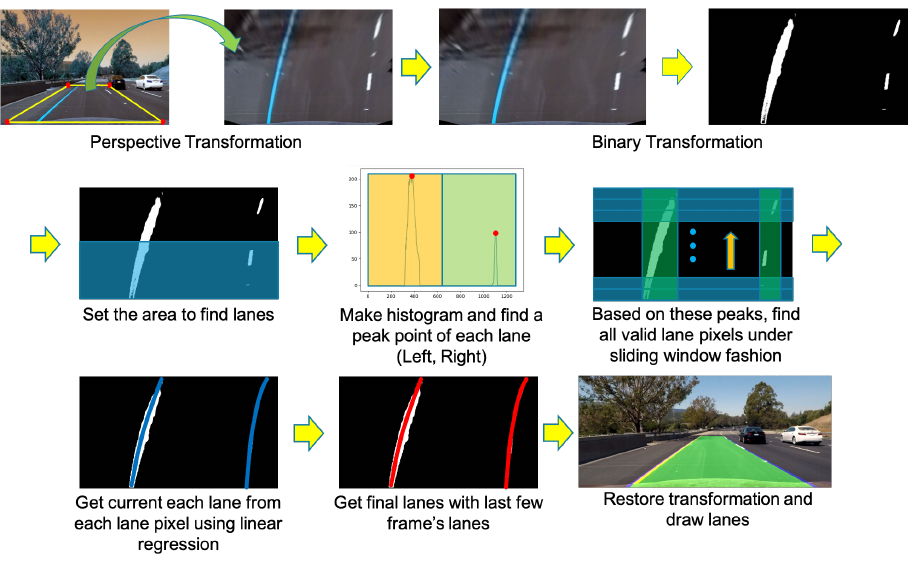
Figure 8. Lane recognition process using binary